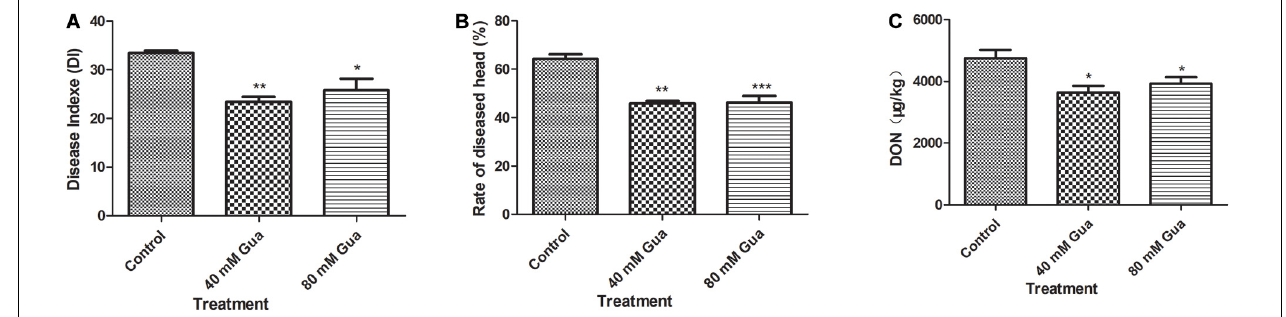
FIGURE 7 | Effects of guaiacol on (A) Diseade Indexe, (B) Rate of diseased head and (C) DON content in the wheat grain. * p < 0.05, ** p < 0.01, and *** p < 0.001.